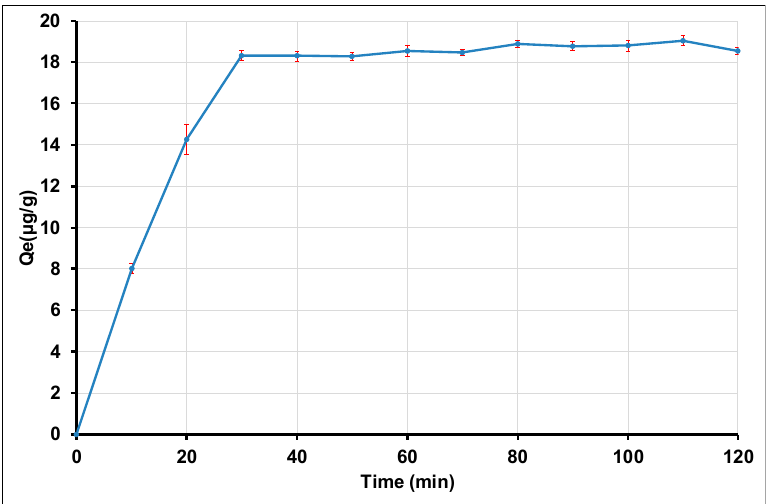
Figure 8. Effect of agitation time of Tl(I) adsorption on γ ANPs.